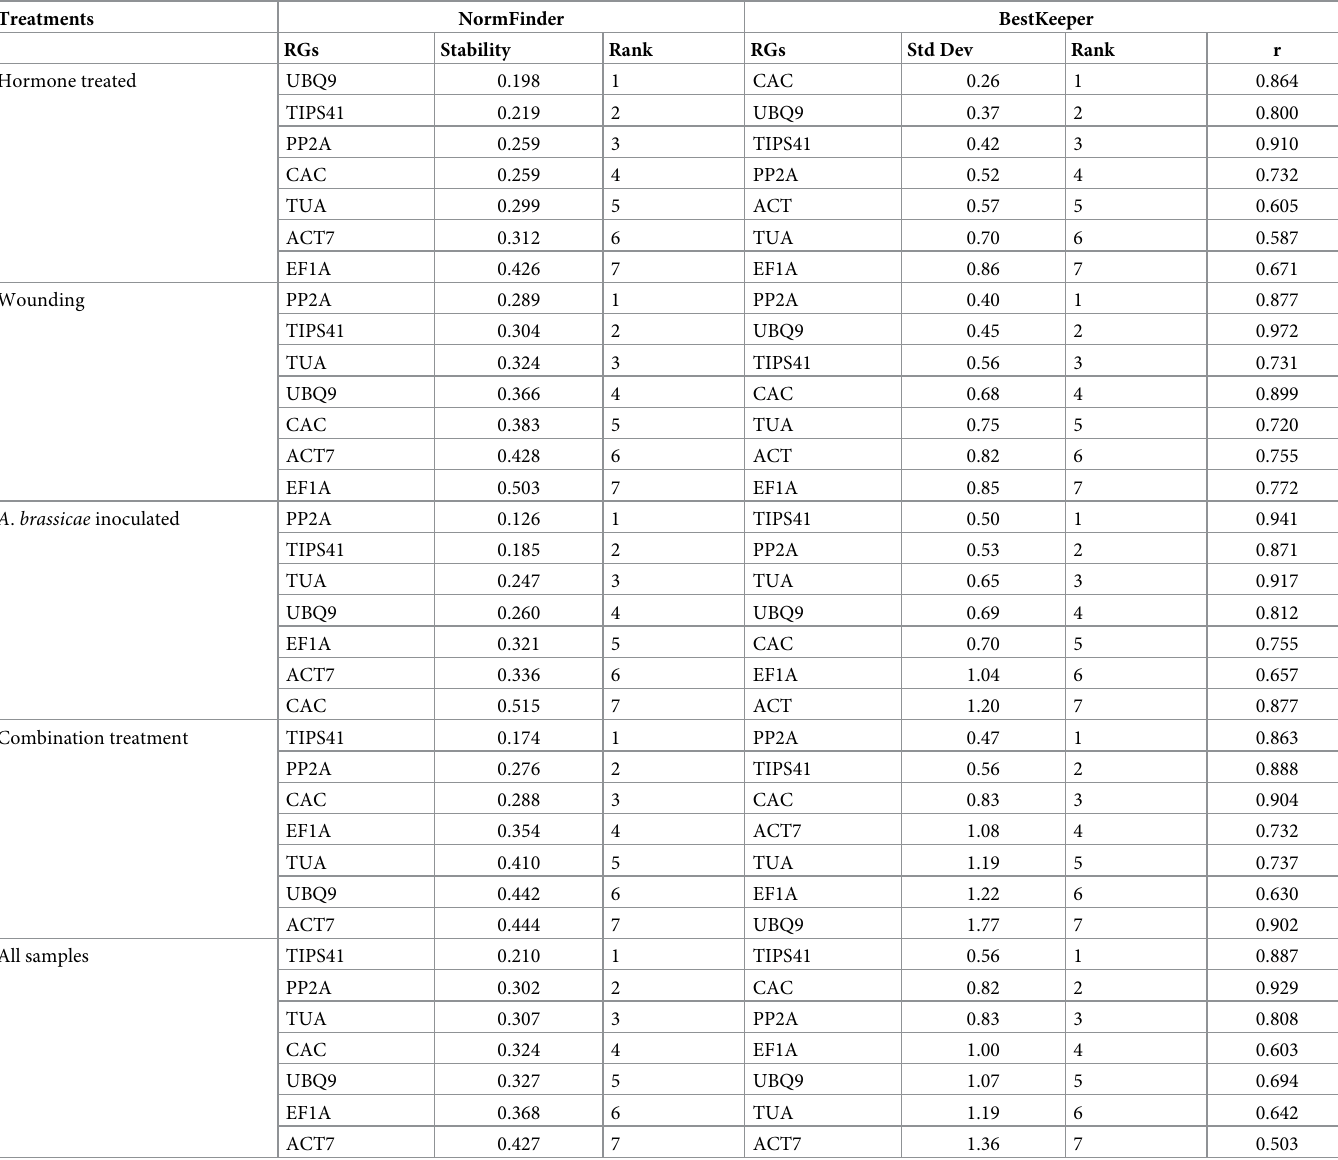
Table 2. Expression stability and ranking of RGs in B . juncea under different experimental conditions identified by Normfinder and BestKeeper software.